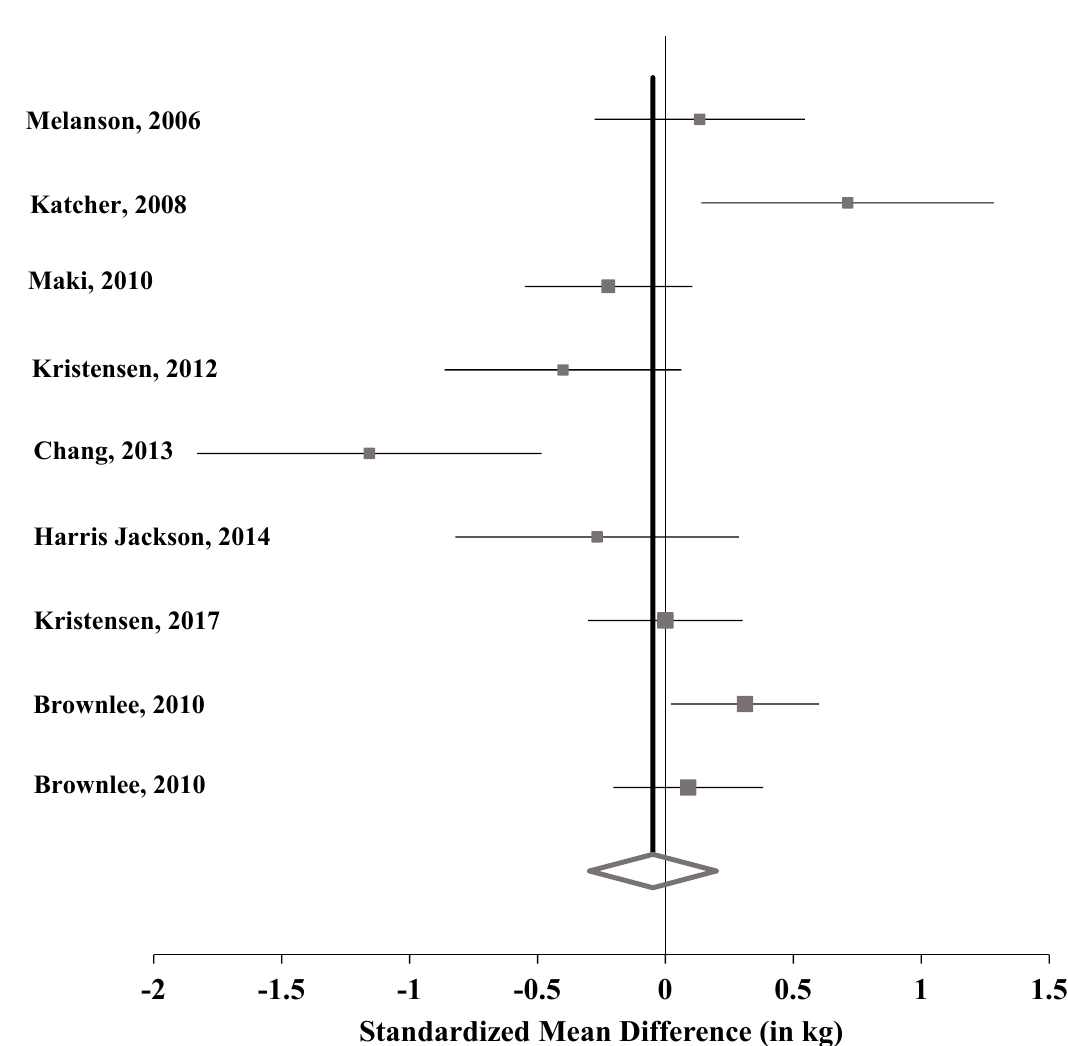
Figure 4. Synthesis forest plot of included studies (values to the left of the line indicate net weight loss for the whole grain intervention).